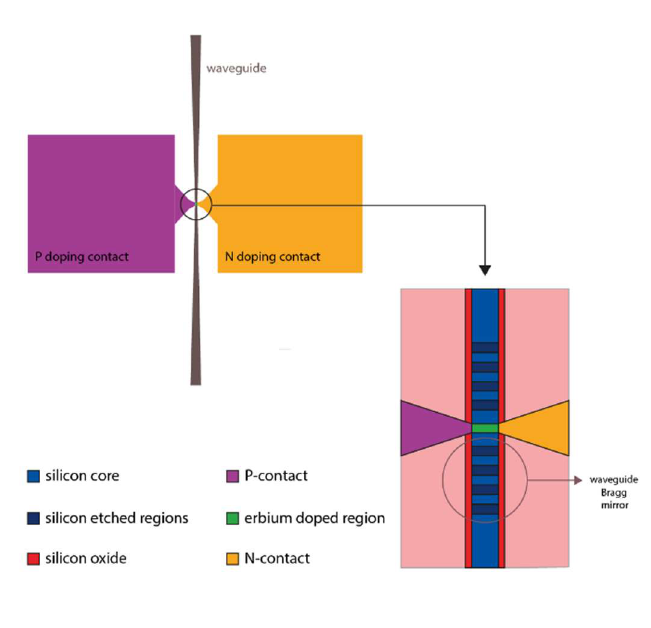
Fig. 1. Sketch of the